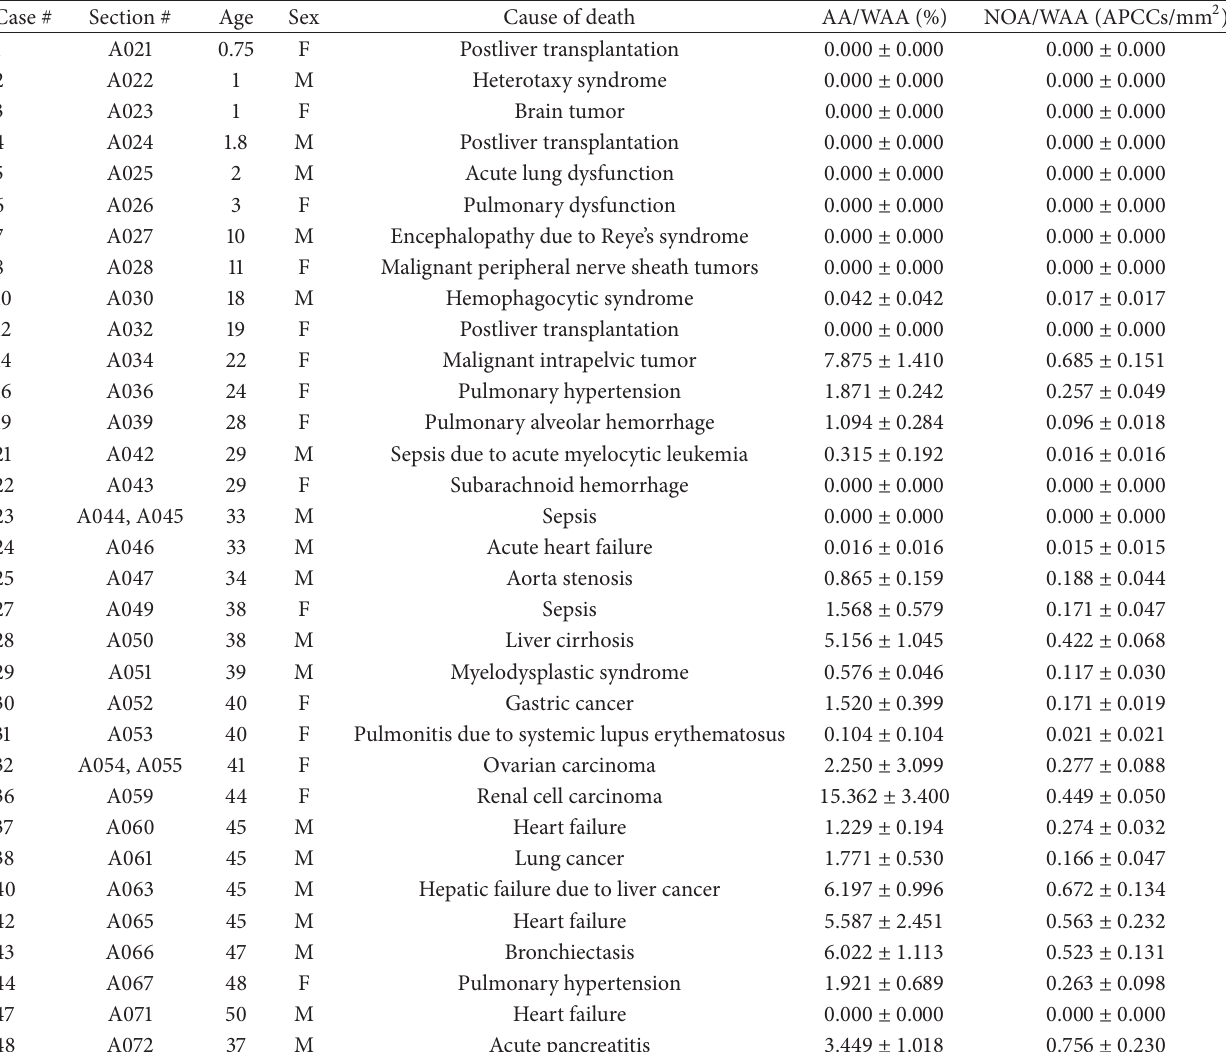
Table 1: Patient characteristics, AA/WAA, and